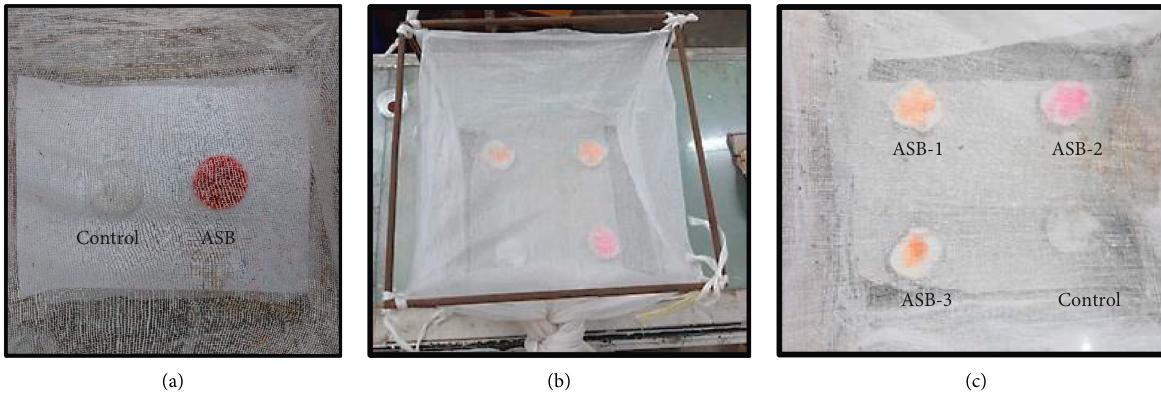
Figure 1: Cage bioassay with Aedes aegypti adults ( n � 50, 25 males and 25 females). (a) Prescreening cage with a control (10% sucrose solution) and one ASB placed at two sides. (b) Screening cage with three ASBs (e.g., ASBs 1, 2, and 3) and a control (10% sucrose solution) bait placed in four corners. (c) Inside view of screening cage with three ASBs and a